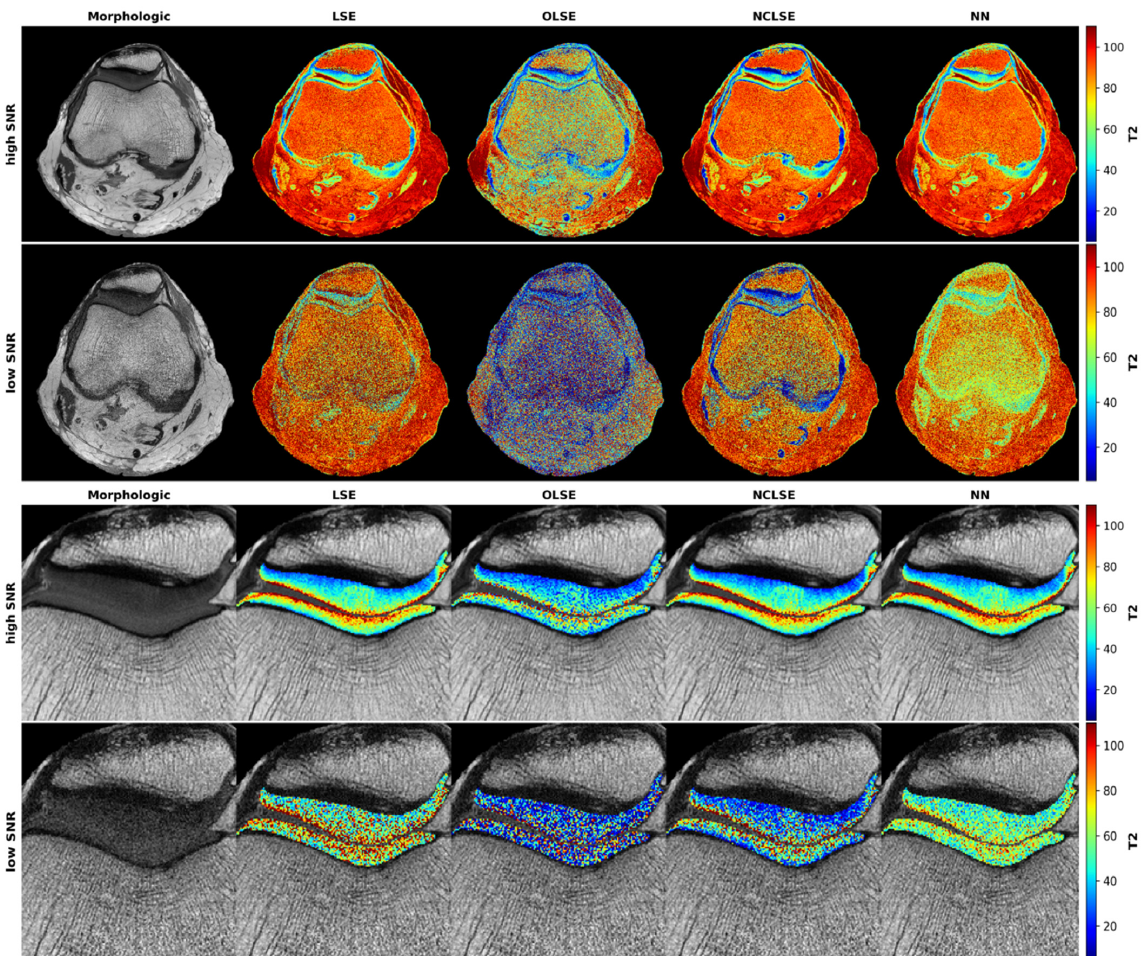
Figure 3. Representative T2 maps as a function of signal-to-noise ratio (SNR) and underlying fitting method. Visualization of the axial plane acquired at high SNR (first row) and at low SNR (second row) of the entire joint that was cropped and zoomed to the patellofemoral compartment (third and fourth rows for high- and low-SNR images) in this representative knee joint. The first column shows the T2-weighted morphologic images (TE = 30 ms). The second to fifth columns visualize the T2 maps following fitting based on the Least-Squares Estimation (LSE, second column), Offset LSE (OLSE, third column), Noise-Corrected LSE (NCLSE, fourth column), and the Neural Network (NN, fifth column). T2 relaxation times [ms] are color-coded as indicated by the scale bars on the right (range: 0–110 ms).